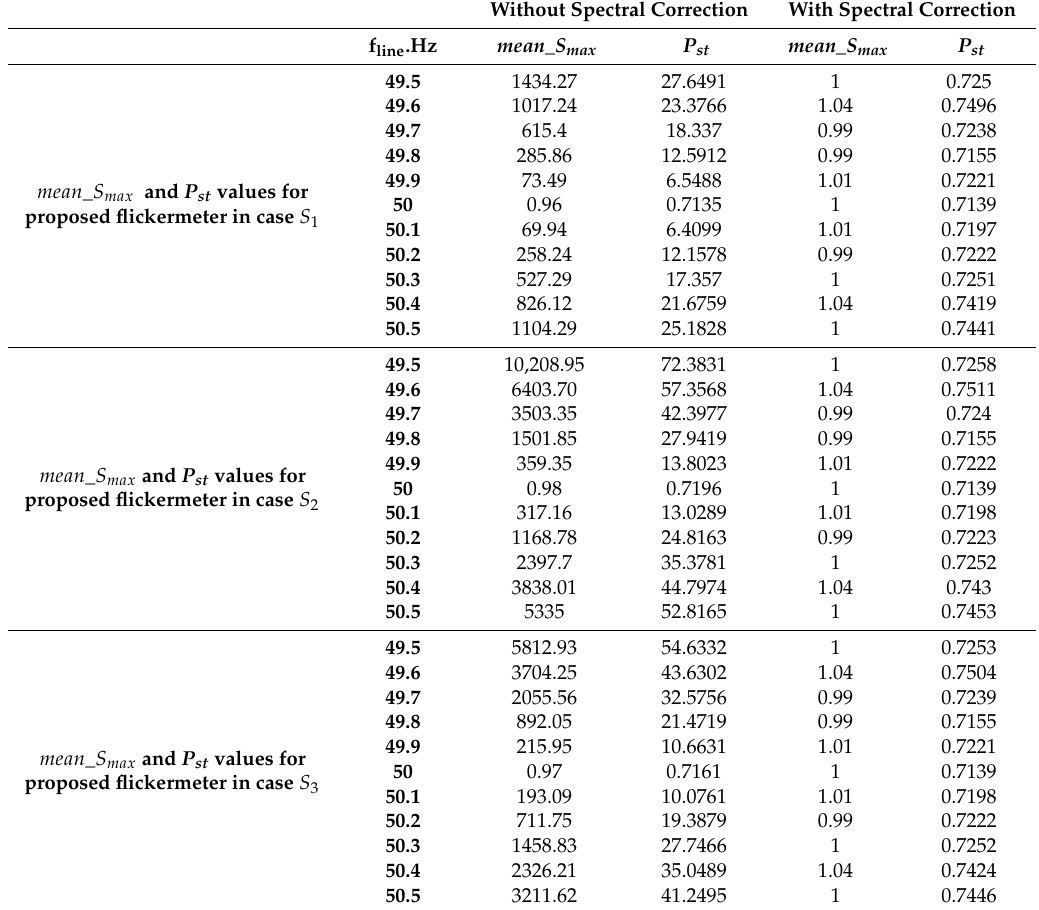
Table 3. mean _ S max and P st values for proposed flickermeter with 940 Hz interharmonic. Without Spectral Correction With Spectral Correction f line .Hz mean _ S max P st mean _ S